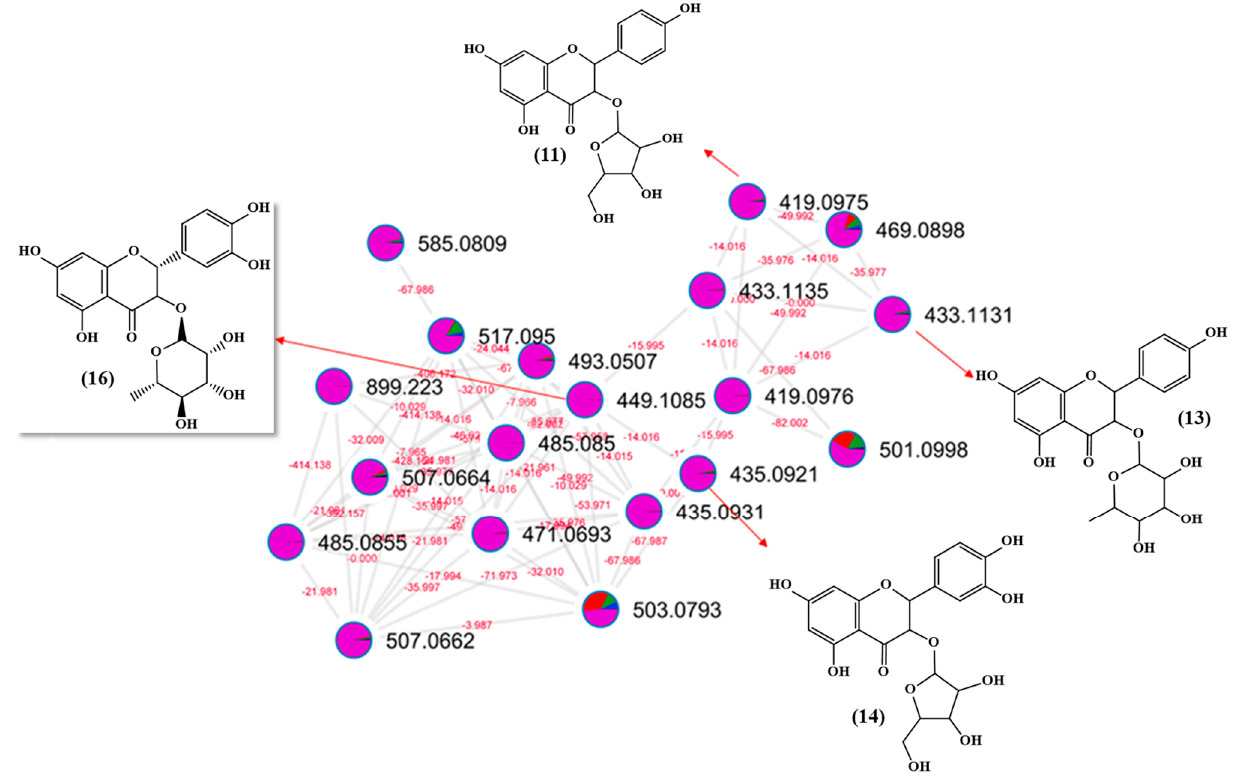
Figure 2. Astilbin ( 16 ) molecular network: molecular family of flavonol glycosides and phenolic compounds from a methanolic extract of A. uleanus . Color nodes: roots (blue), bark (green), stem bark (red), leaves (purple), and blank (black).